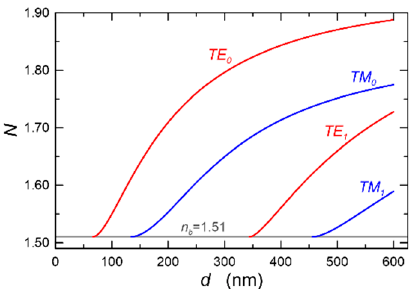
Figure 14. Images of the excited slab waveguides. ( a ) TM 0 mode, ( b ) TE 0 mode, λ = 676.7 nm.